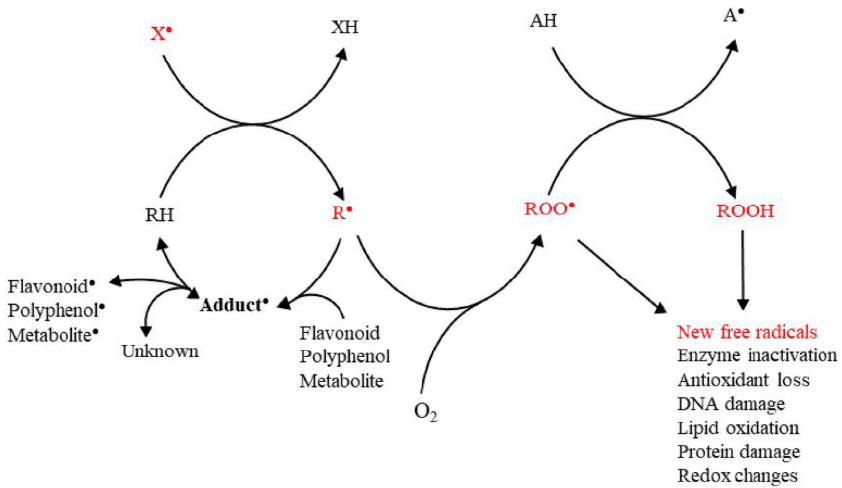
Figure 3. Schematic depiction of the action of highly reactive free radical species and their inhibition by phenolic compounds. Reprinted (adapted) with permission from [66].